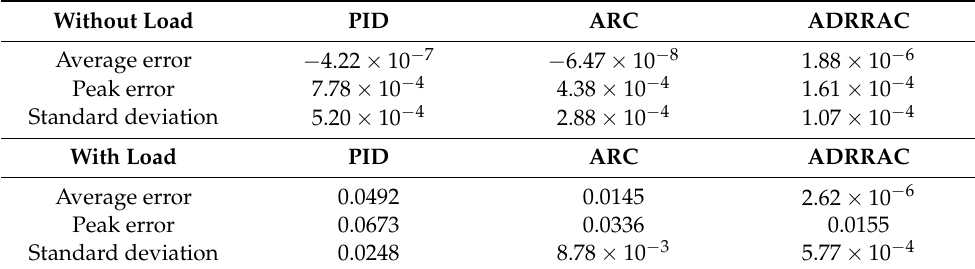
Table 2. Performance indicators of 1 Hz sinusoidal